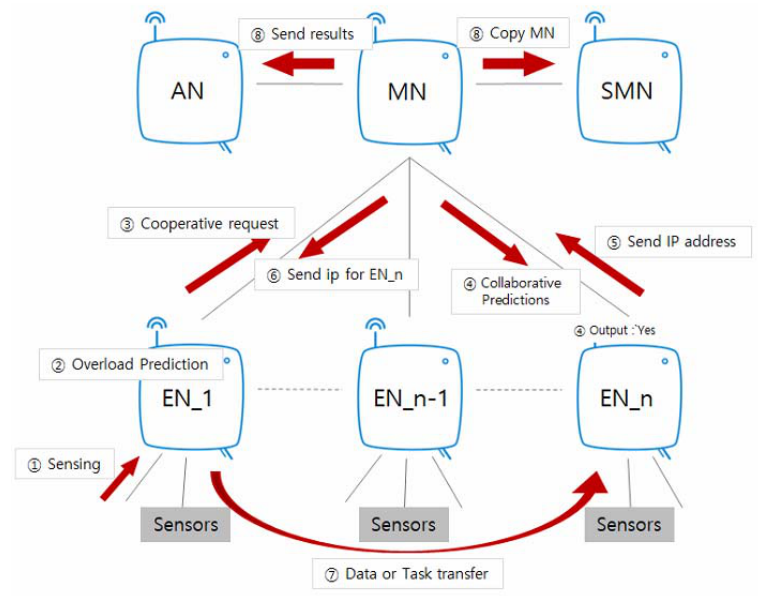
Figure 5. Dynamic o ffl oading model processing Figure 5. Dynamic offloading model processing overview.